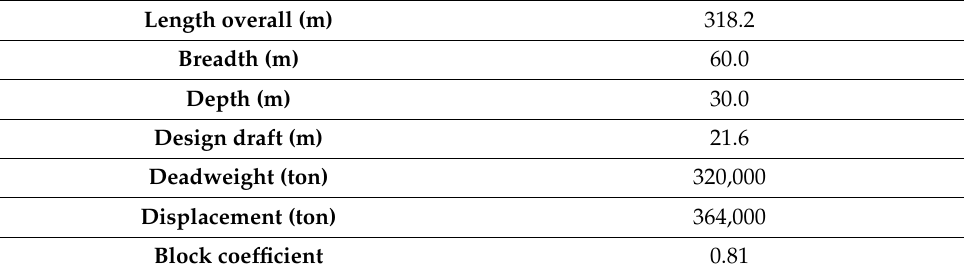
Table 1. Principal particular of the target structure.